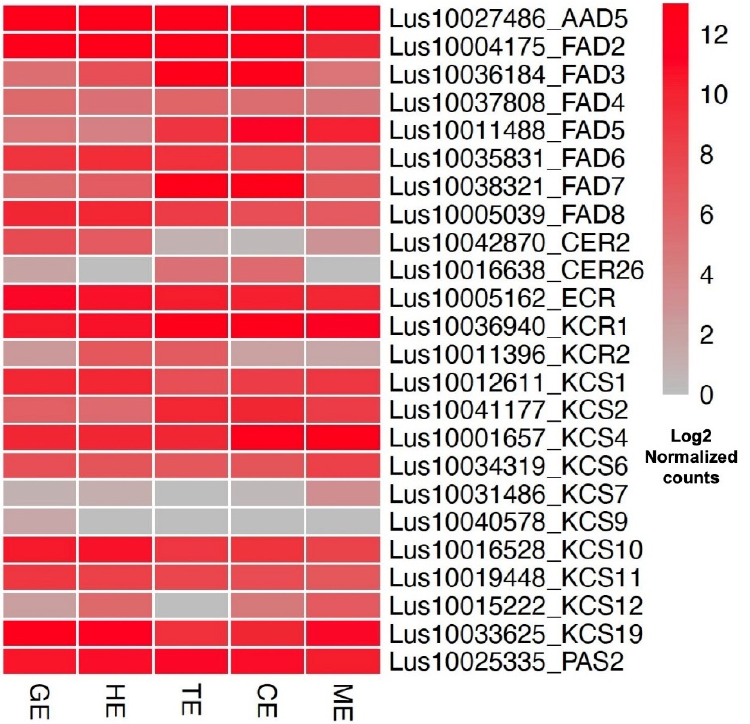
Figure 6. Expression of fatty-acid metabolic genes during embryonic developmental process in flax. Heatmap of the expression level of fatty-acid metabolic genes in five embryo developmental stages. Expression levels calculated using Log 2 transformed normalized counts are indicated by color gradient, from red (high) to grey (low) in the five stages of embryogenesis.